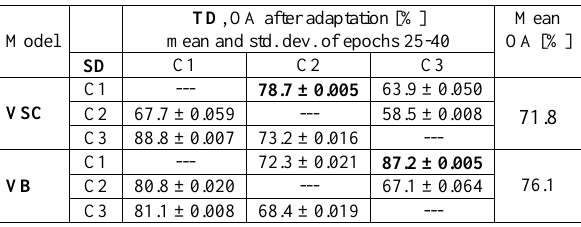
Table 7. Mean OA and standard deviation on the target